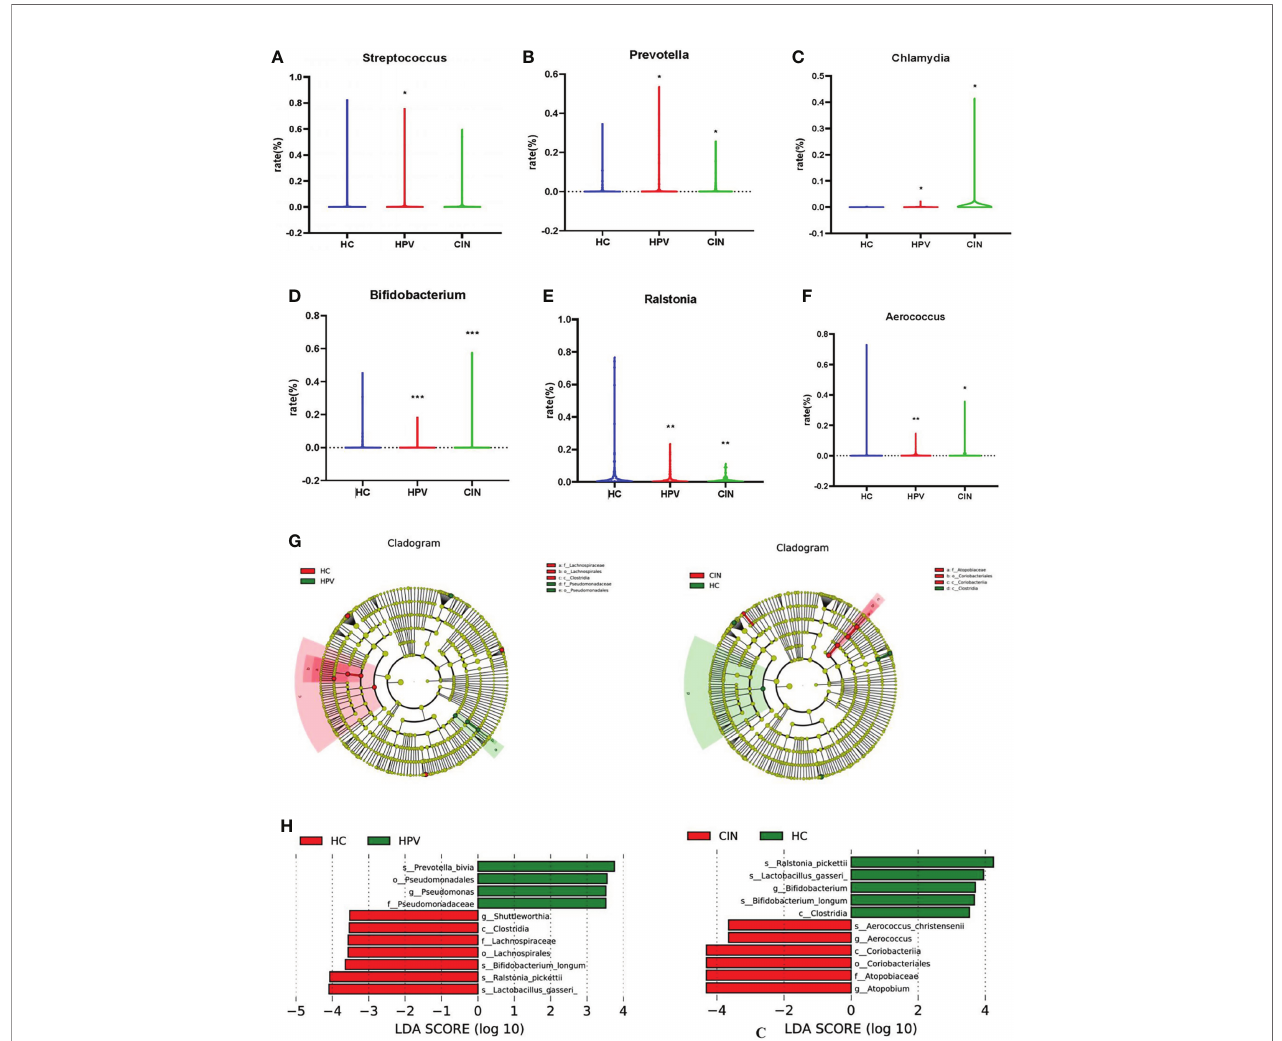
FIGURE 4 | Bacterial Taxa Analysis. (A) Streptococcus was signi fi cantly higher in HPV-infected group than HC group. (B, C) Prevotella and Chlamydia were the bacterial species that signi fi cantly higher in HPV- infected group and CIN-diagnosed group than HC group. (D, E) Bi fi dobacterium and Ralstonia were signi fi cantly lower in HPV-infected group and CIN-diagnosed group than HC group. (F) Aerococcus was lower in HPV-infected women and higher in CIN-diagnosed women compared with HC women. (G) Cladogram of the LEfSe analysis of the vaginal microbiota in the three study groups. The microbial compositions were compared at different evolutionary levels. (H) LDA scores obtained from the LEfSe analysis of the vaginal microbiota in the different groups. An LDA effect size of >2 was used as a threshold for the LEfSe analysis. LDA, linear discriminant analysis; LEfSe, LDA effect size analysis. Wilcoxon one-side test; * P < 0.05 and ** P < 0.005. HC, healthy control group; HPV, HPV-infected group; CIN, CIN-diagnosed